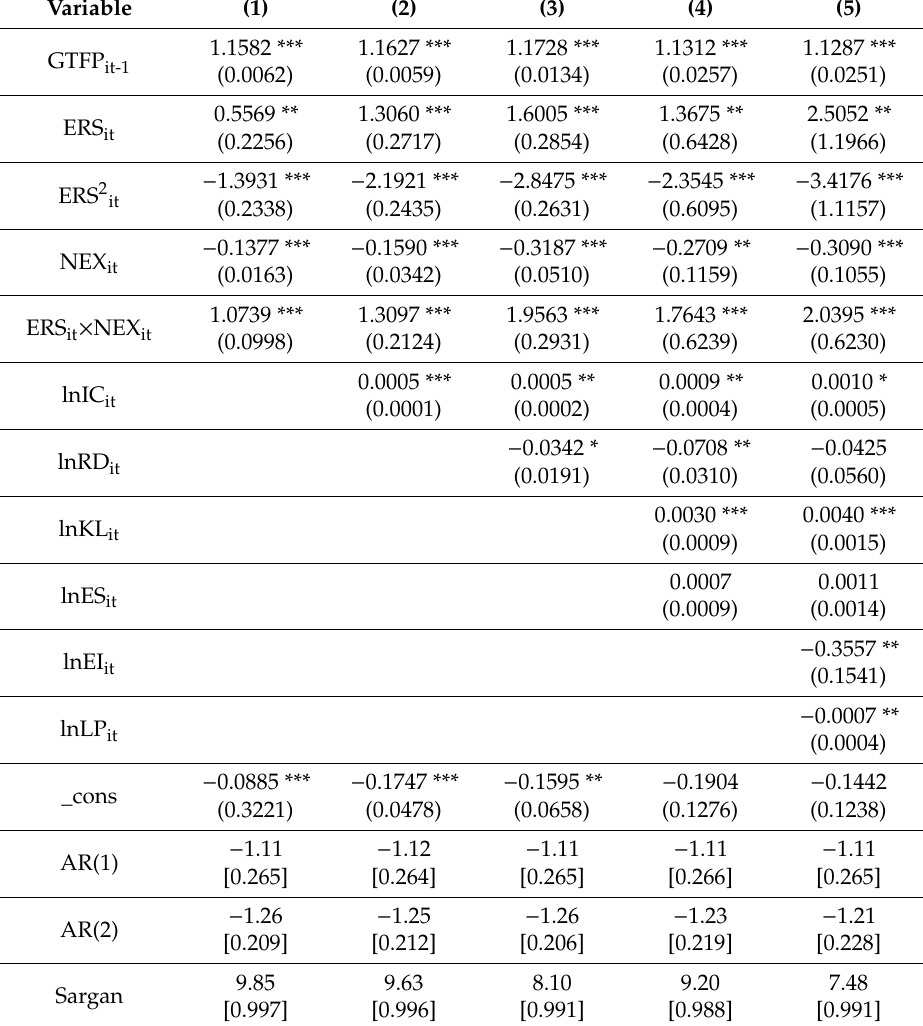
Table 2. Estimation